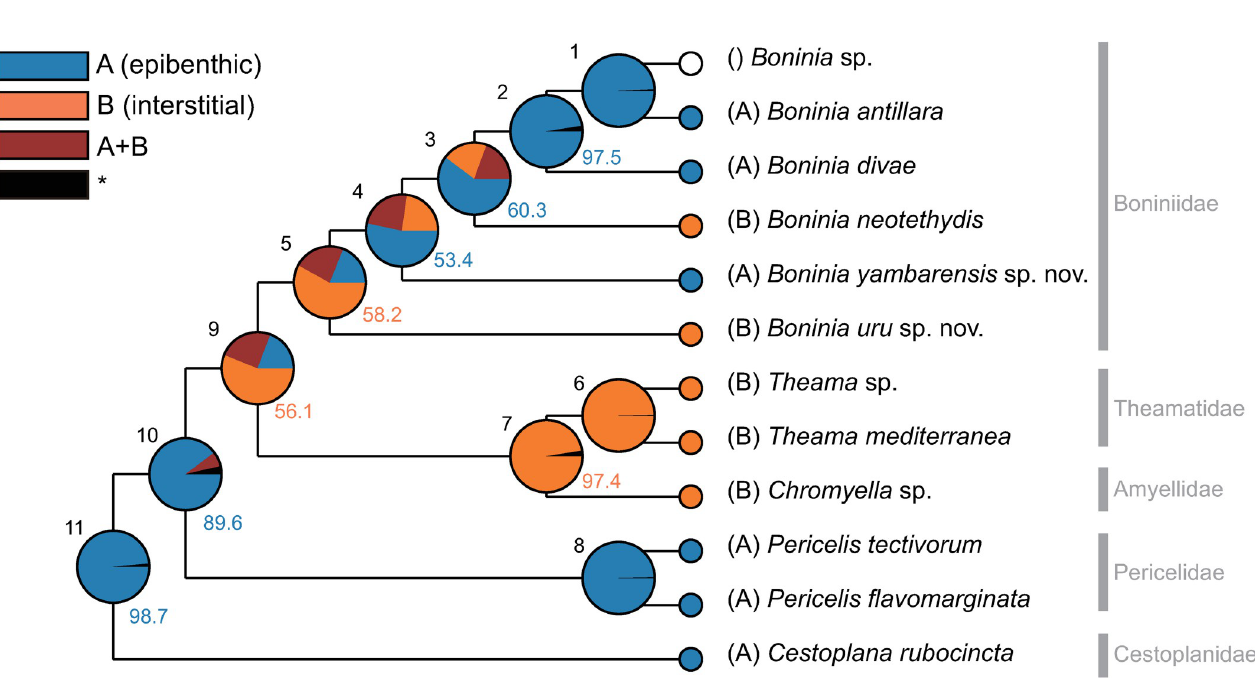
Fig 8. Ancestral reconstruction of habitats produced using Bayesian Binary Markov chain Monte Carlo analysis. Nodes are numbered. Pie charts on nodes show the probabilities of possible ancestral states with numbers representing the highest probabilities (%). � , ancestral state with a relative probability < 5%.